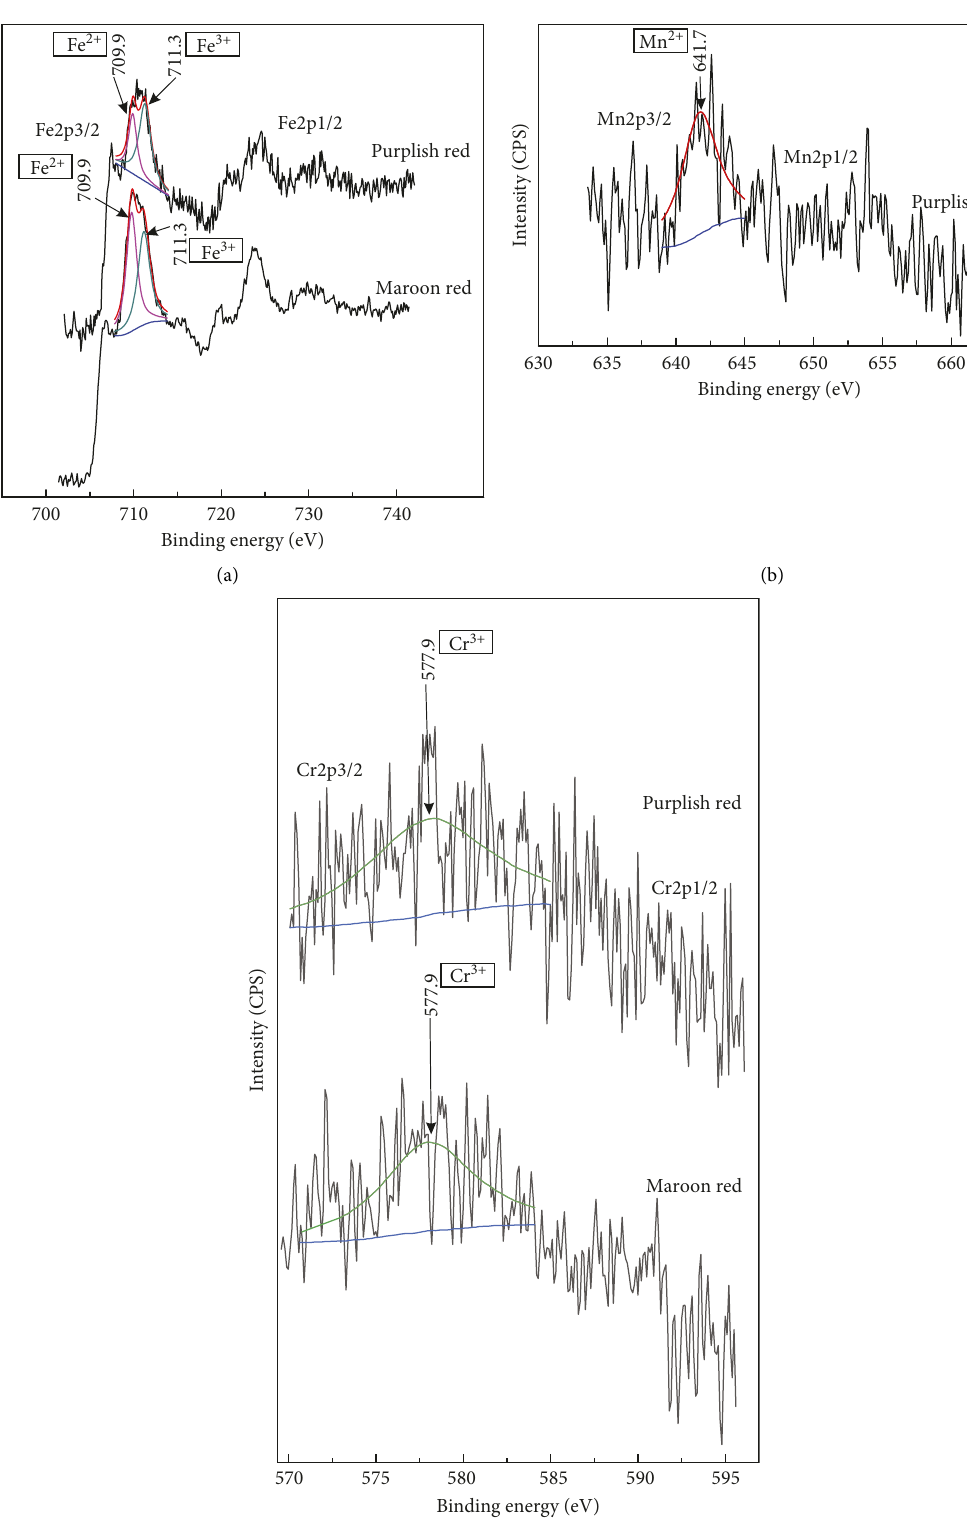
Figure 6: X-ray photoelectron spectra for Fe2p, Mn2p, and Cr2p. ((a) Fe2p, (b) Mn2p, and (c)